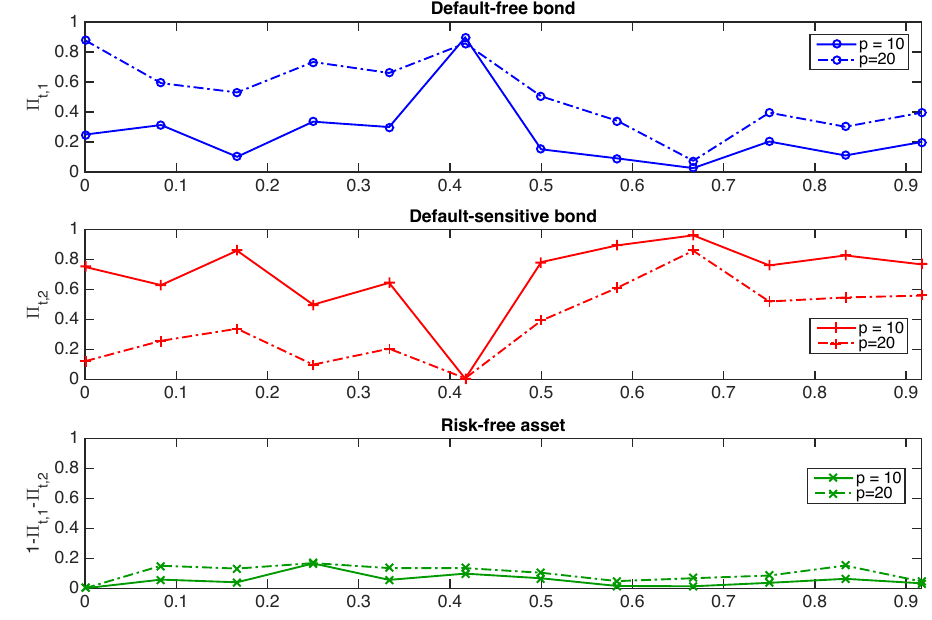
Figure A1. Sensitivity of optimal strategies to a change in the degree of risk aversion.